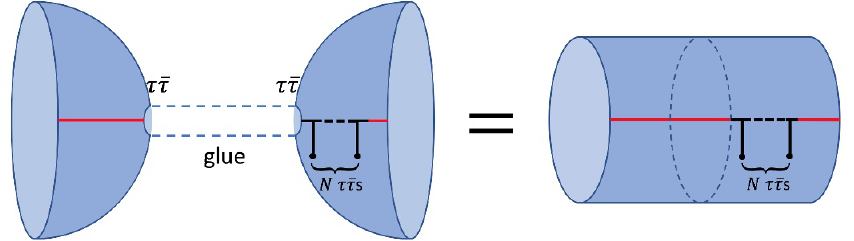
Figure 9 . Connected sum of two disks creates a cylinder. The disk on the left has a single hole, attached to which is a (cid:28) (cid:22) (cid:28) . The disk on the right has N + 1 holes, respectively attached with N + 1 (cid:28) (cid:22) (cid:28) ’s. The resultant cylinder has N (cid:28) (cid:22) (cid:28) ’s. If N = 0, the cylinder stay in its ground state